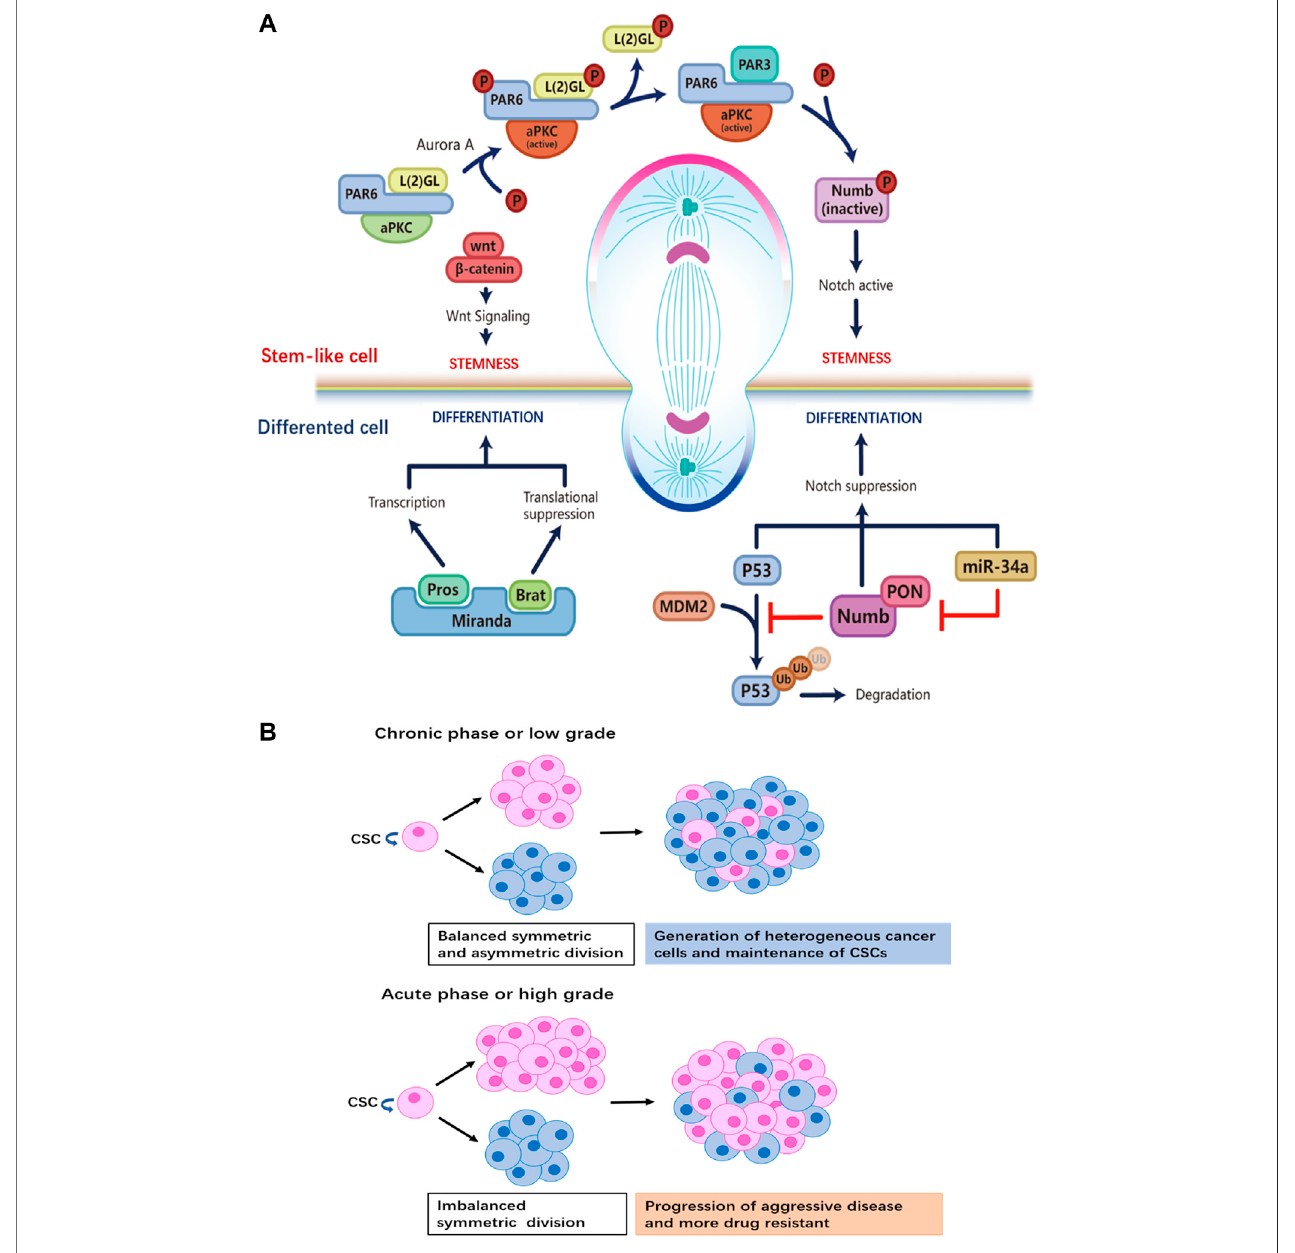
FIGURE 1 | (A) Distinct regulatory machineries are involved in the two daughter cells during ACD of stem cells. Stem cell at the apical pole: formation of the aPKC/ PAR6/PAR3 complex plays a crucial role for the establishment of the ‘ self-renewal ’ identity at the apical pole. Aurora-A protein kinase activates aPKC, which then phosphorylates L(2)GL; then L (2)GL isreleased from the complex and replaced byPAR3. The aPKC/PAR6/PAR3 complex phosphorylates Numb, releasing itfrom the apicalmembrane.PONbringsNumbtothebasalpolethatwillbecomethedifferentiateddaughtercell.ByremovingNumb,Notchsignalingisactivetomaintainthe stemness of the daughter cell at the apical side. Wnt signaling also participates in promoting self-renewal in the daughter cell, though details of the mechanism are not known. Differentiated cell at the basal pole: the adapter protein Miranda recruits Prospero and Brat. As a translational repressor, Brat suppresses the synthesis of proteins necessary for proliferation. The transcription factor Prospero promotes the expression of genes that drive differentiation after Miranda is degraded. Ubiquitination-dependent degradation of P53 is inhibited by Numb, while the miR-34-Numb-Notch feedback loop suppresses Notch level and favors differentiation in the daughter cell. (B) The relationship between tumor progression and the ratio of CSCs that undergo ACD versus SCD. When SCD and ACD are balanced, tumor generates heterogeneity while maintaining the pool of CSCs. On the other hand, a switch from ACD to SCD in CSCs results in the expansion of the stem cell pool.